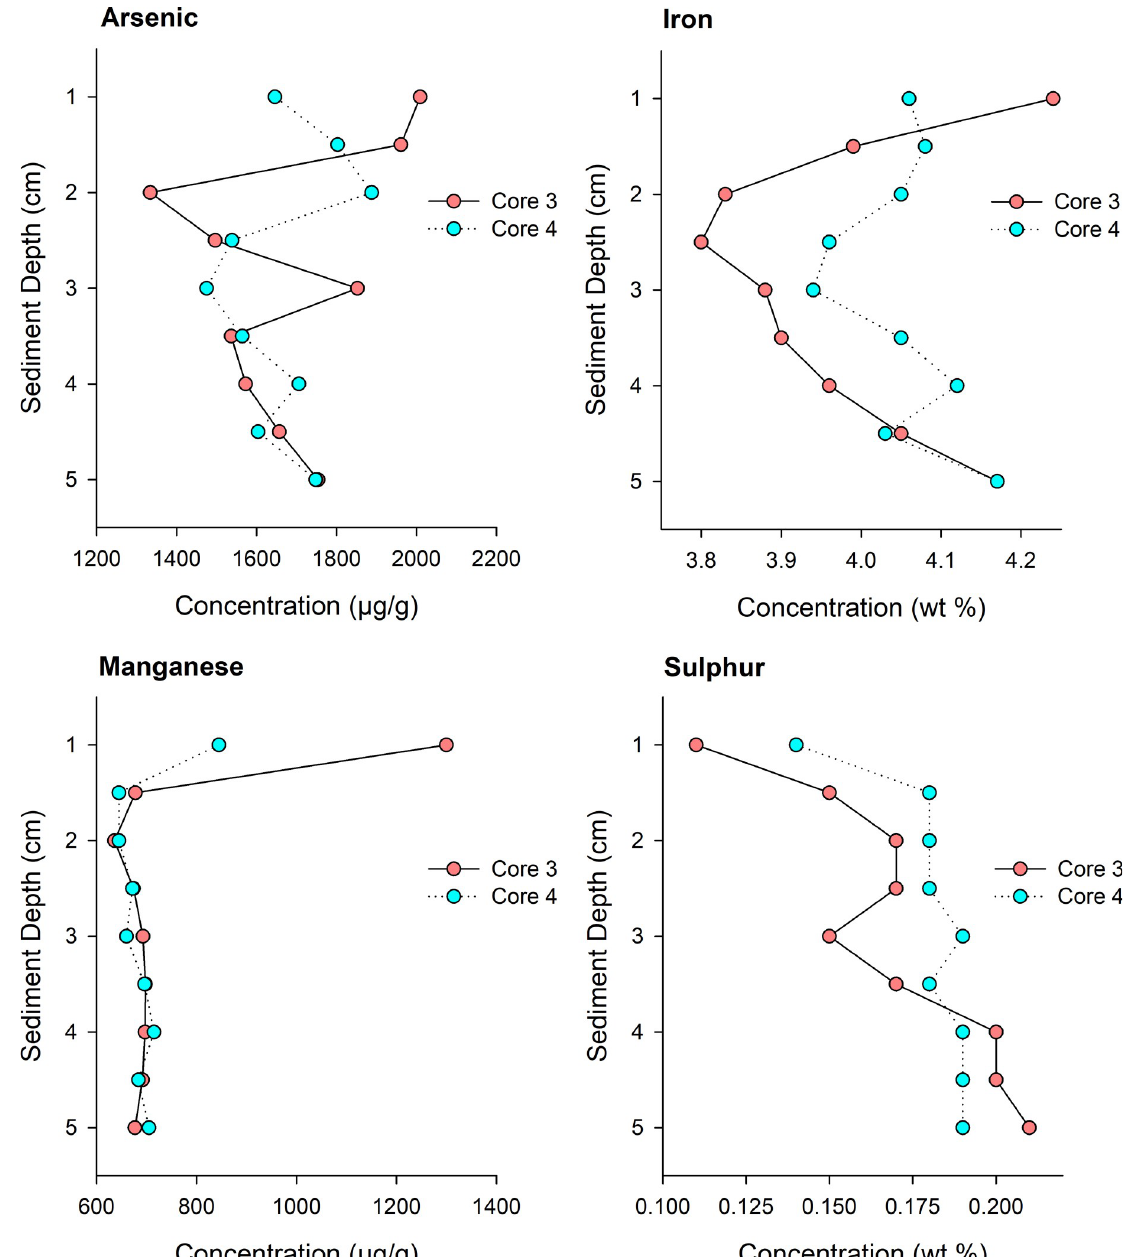
Fig 2. Sediment profiles of element concentrations. Profiles of As, Fe, Mn and S concentrations in the top 5 cm of sediment in the Yellowknife Bay experimental cores. Martin Lake cores (~15 mg/L) and slightly increased halfway through the experiment in one of the Yellowknife Bay cores. The ORP values were positive, indicated oxidizing conditions in the water column of all cores throughout the experiment. The ORP increased continuously in the Lower Martin Lake cores during the experiment (likely due to photosynthesis of algae at the sediment surface), while in the Yellowknife Bay cores, the ORP decreased slightly at the begin- ning though remained positive for the remainder of the experiment.